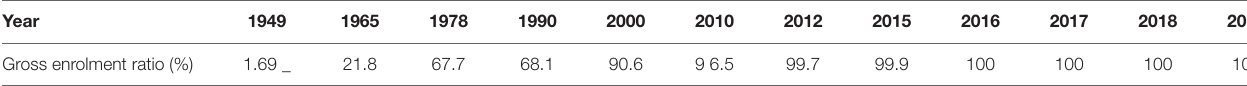
TABLE 3 | Changes in China’s gross enrollment rate.